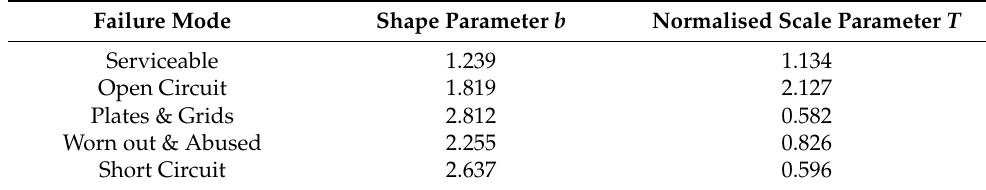
Table 2. Determined Weibull parameters for the failure modes of the total sample. The table shows the estimated shape parameter b for each failure mode and the normalised scale parameter T by a typical vehicle lifetime τ vehicle . (Analysis method: MLE; Rank method: Median ranks; Confidence bounds method: Fisher matrix; unbiasing